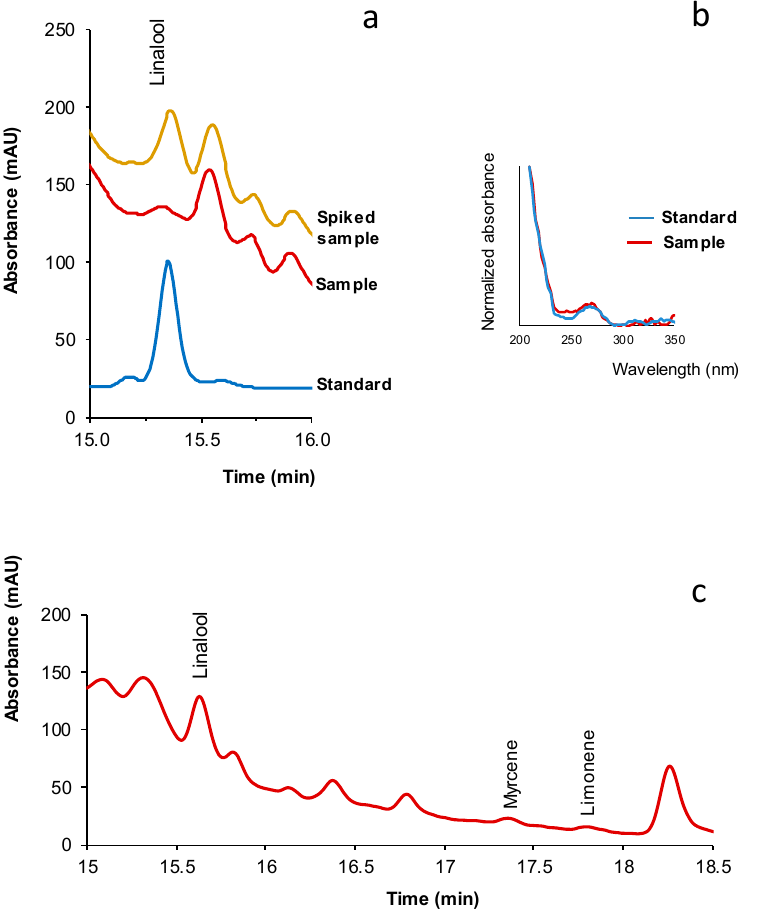
Figure 2. ( a ) Chromatograms obtained for a standard solution of linalool (5 µg mL − 1 ), for the extract of sample FB-1, and the same extract spiked with linalool (1 µg mL − 1 ). ( b ) normalized spectra of linalool and the peak attributed to linalool in the chromatogram of sample FB-1. ( c ) Chromatogram of the extract obtained for sample FB-2. For other experimental details, see text.